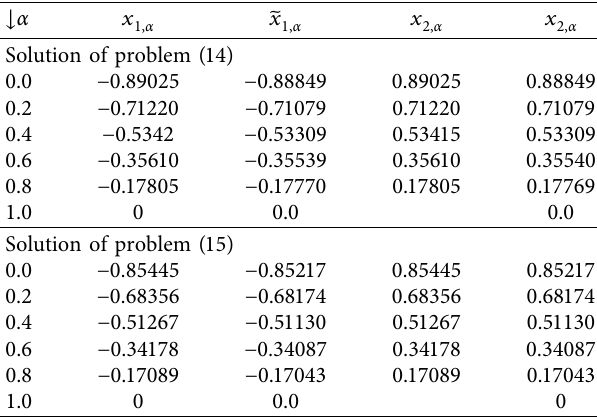
, x and approximate 􏽥 x 1 , α 2 , α